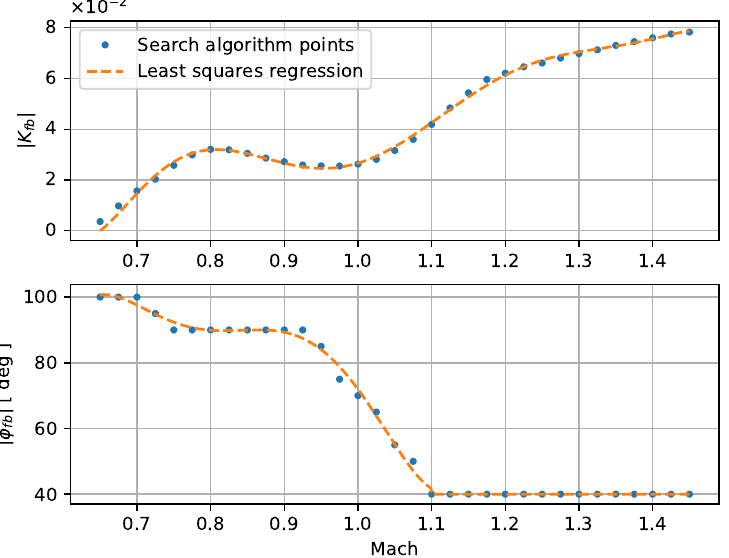
Figure 11. Control law for a 3 DOF airfoil in compressible flow as a function of Mach